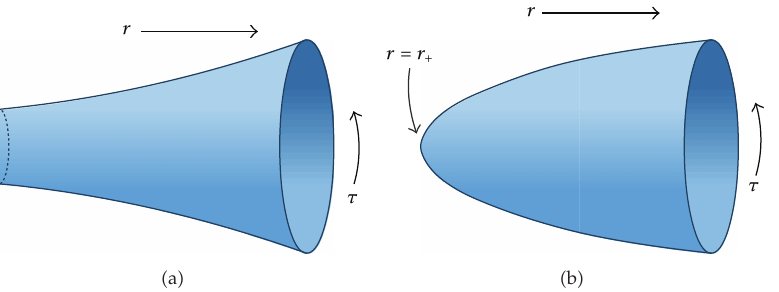
Figure 7: The topology of the thermal AdS geometry and the AdS-Schwarzschild geometry. (cid:2) a (cid:3) thermal AdS. (cid:2) b (cid:3)